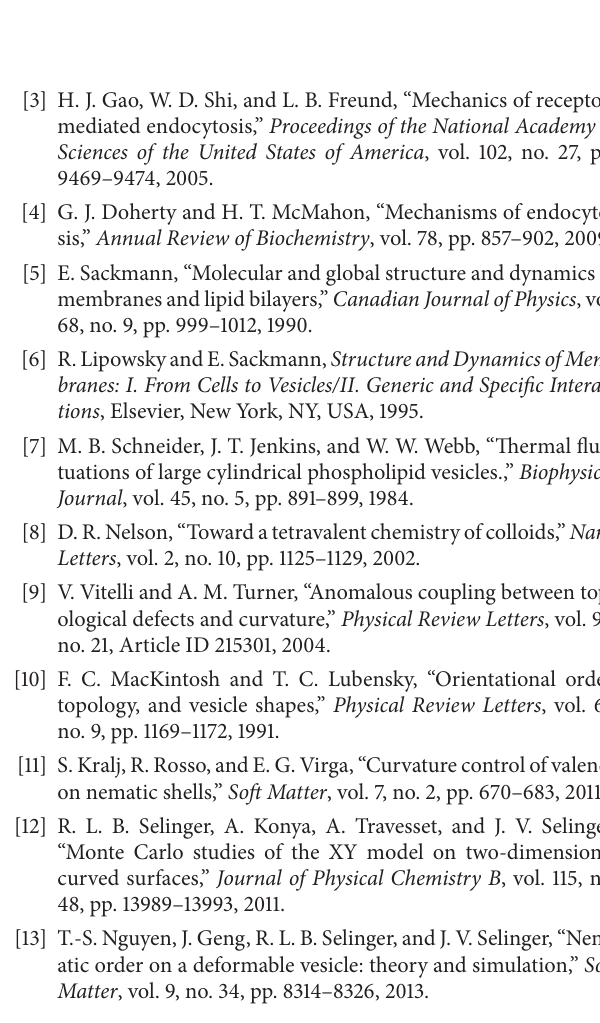
= 40 and 𝑡 = −0.03 . The vesicle shape is prolate with the 0